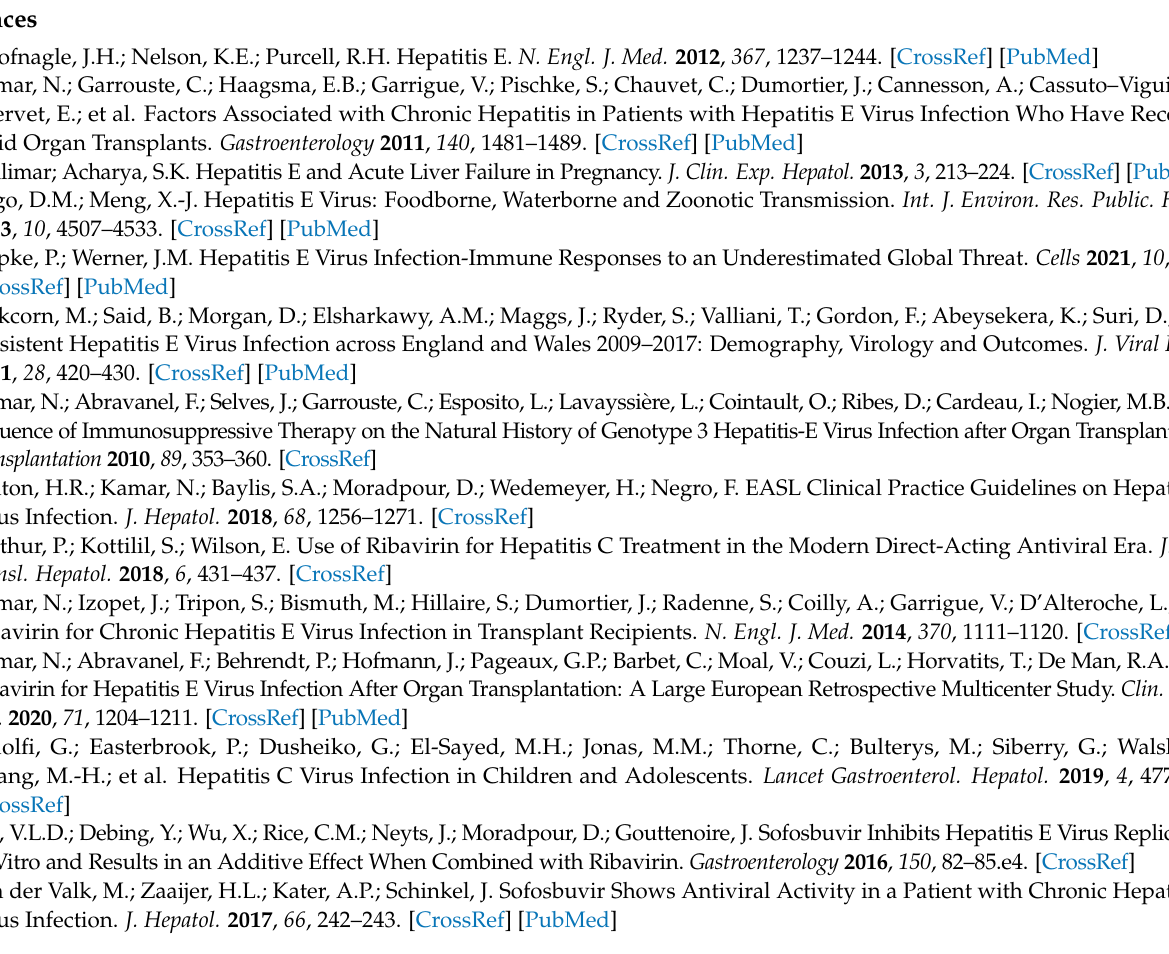
Treatment; Figure S2: NK Cell Function after Sofosbuvir Treatment; Figure S3: Effect of Ribavirin Treatment on Further JAK-STAT Signaling; Figure S4: Selective TYK-2 Inhibition with Cerdulatinib Before Ribavirin